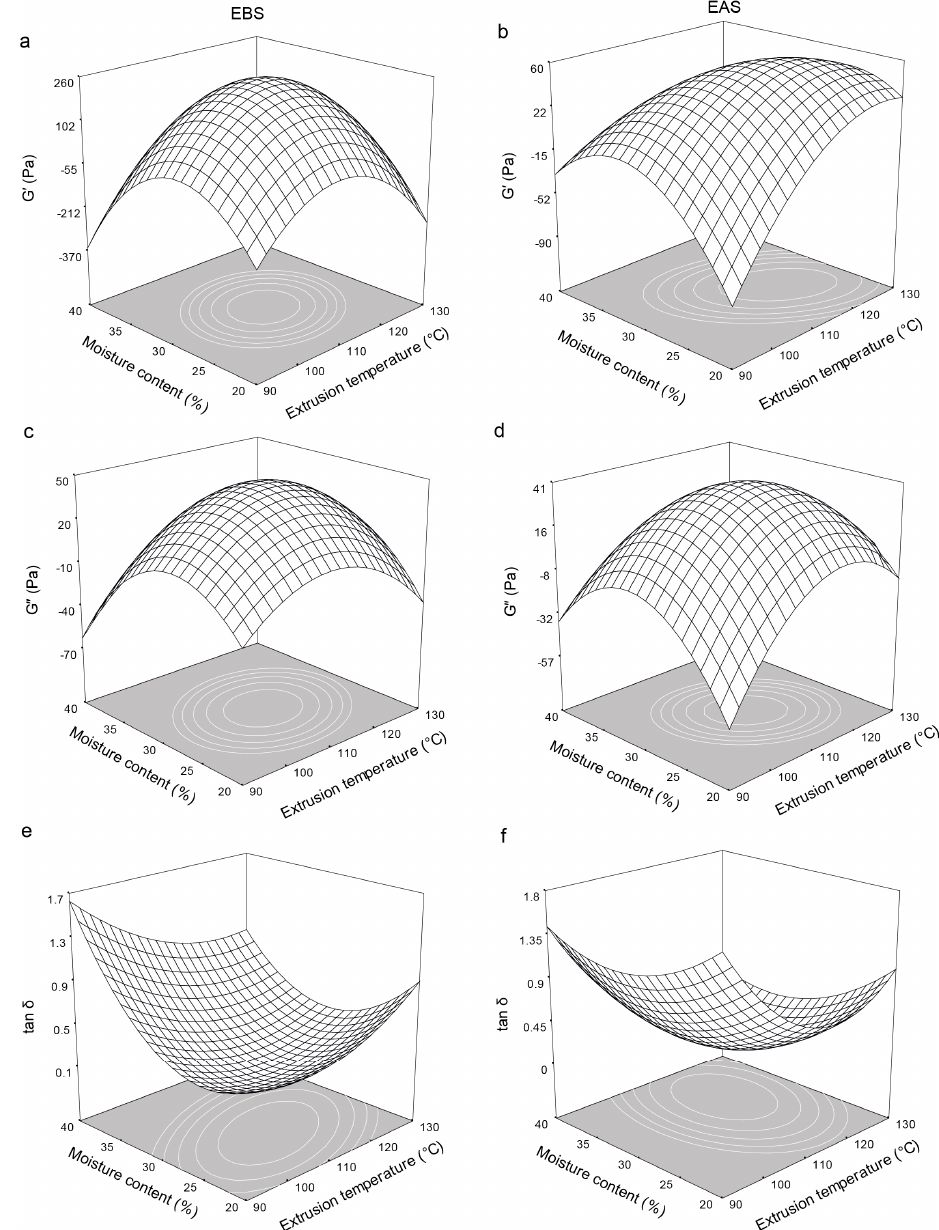
Figure 2. Effect of extrusion temperature and moisture content on: loss modulus (G’), stored modulus (G”) and the ratio of loss modulus/storage (tan δ ) at a screw speed of 280 rpm on extruded flours before the storage (EBS) and extruded flours after the storage at 4 °C for 120 h (EAS). a —G’ of EBS; b —G’ of EAS; c —G” of EBS; d —G” of EAS; e —tan δ of EBS; f —tan δ of EAS.